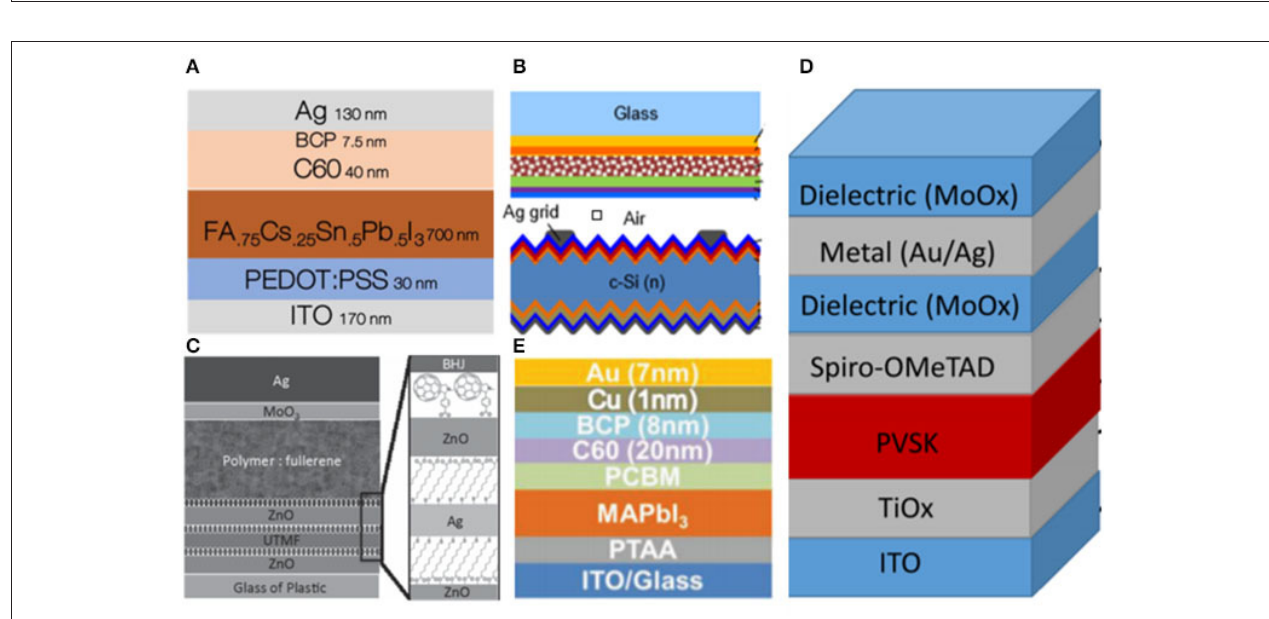
FIGURE 4 | (A) Schematic of the semi-transparent cell architecture (reproduced from ref. 30, copyright 2013, Wiley VCH). (B) Schematic diagram of semitransparent ssDSC device (reproduced from ref. 31, copyright 2013, Wiley VCH). (C) Schematic illustration of the PVSK solar cell structure on an Ag NW/LGO composite electrode (reproduced from ref. 32, copyright 2019, MDPI).